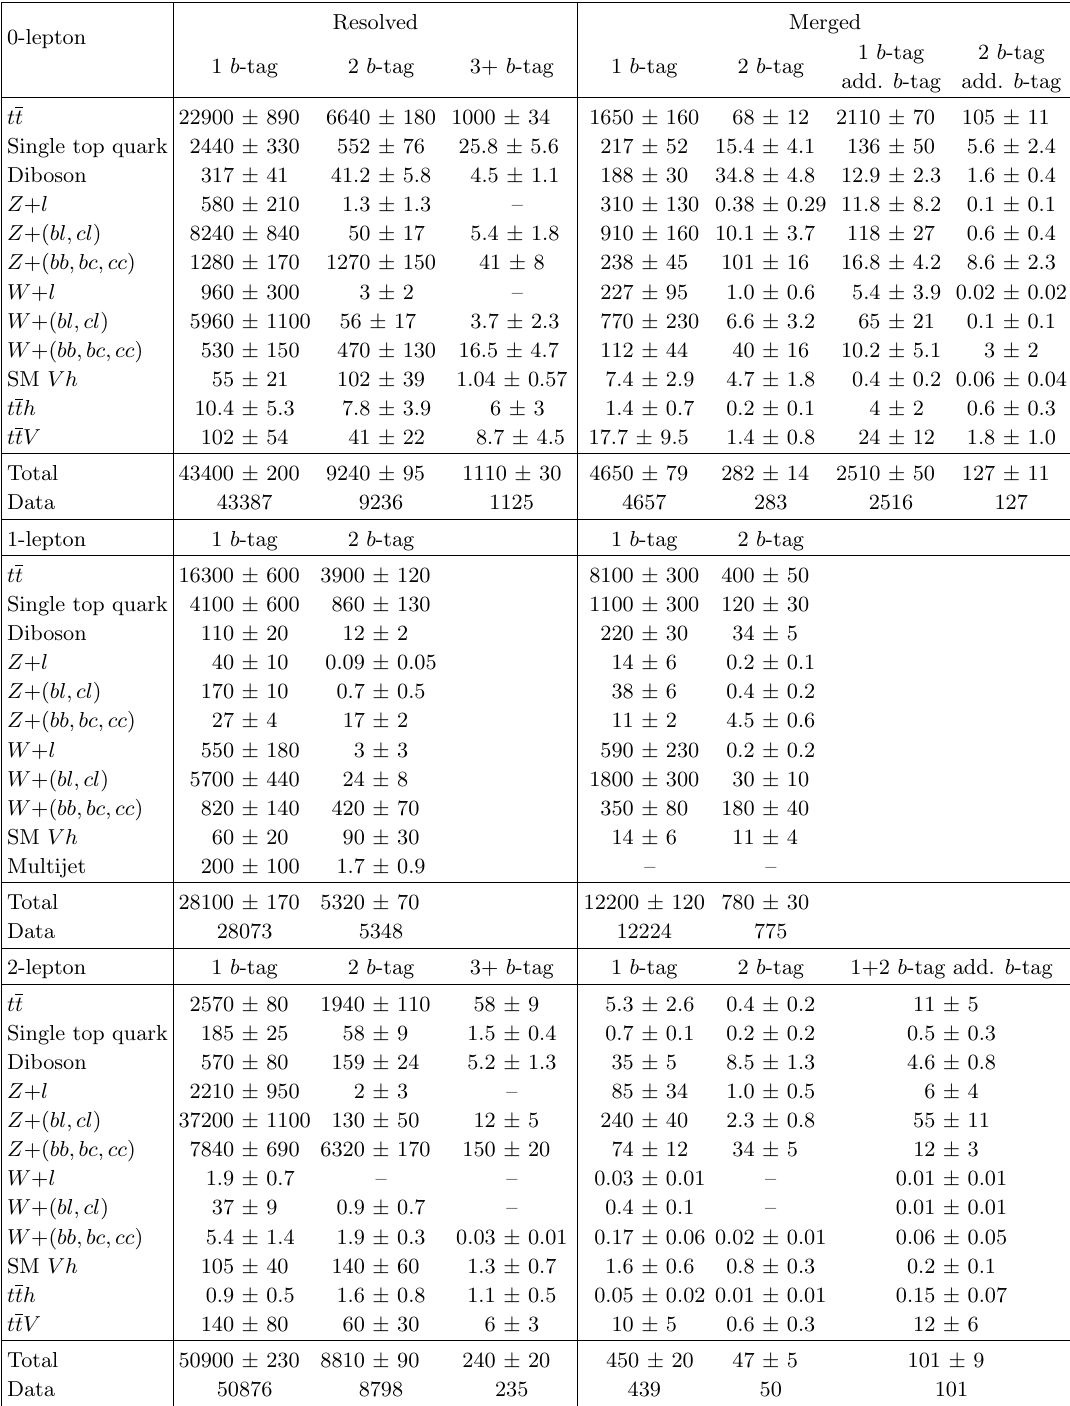
Table 5. The predicted and observed event yields in the signal regions de(cid:12)ned in the text. The yields in the 1 and 2 b -tag regions correspond to the HVT (cid:12)t for a signal of mass 1.5 TeV. In the 3+ b -tag and 1 and 2 b -tag with additional b -tags regions, the yields are from the (cid:12)t using the A boson produced in association with b -quarks as signal with a mass of 1.5 TeV. The quoted uncertainties are the statistical and systematic uncertainties combined in quadrature after the (cid:12)t. The uncertainties in the individual background predictions are larger than the total background uncertainty due to correlations in the normalisation parameters in the